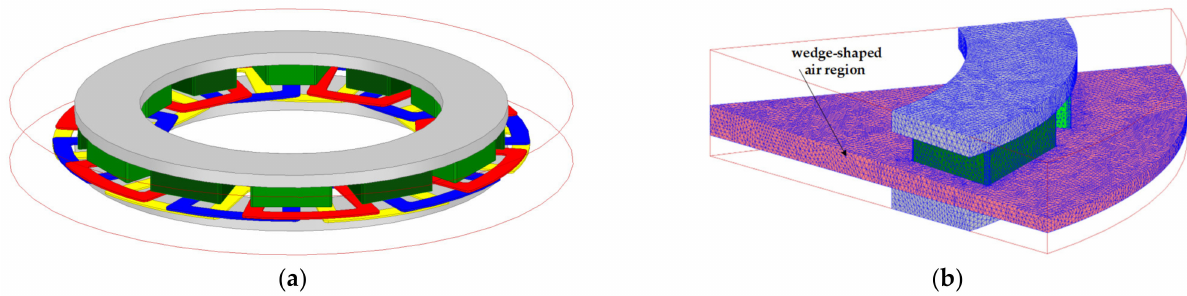
Figure 4. ( a ) 3D FEA model of designed AFPM machine with coreless stator; ( b ) Meshes of rotors and wedge-shaped air